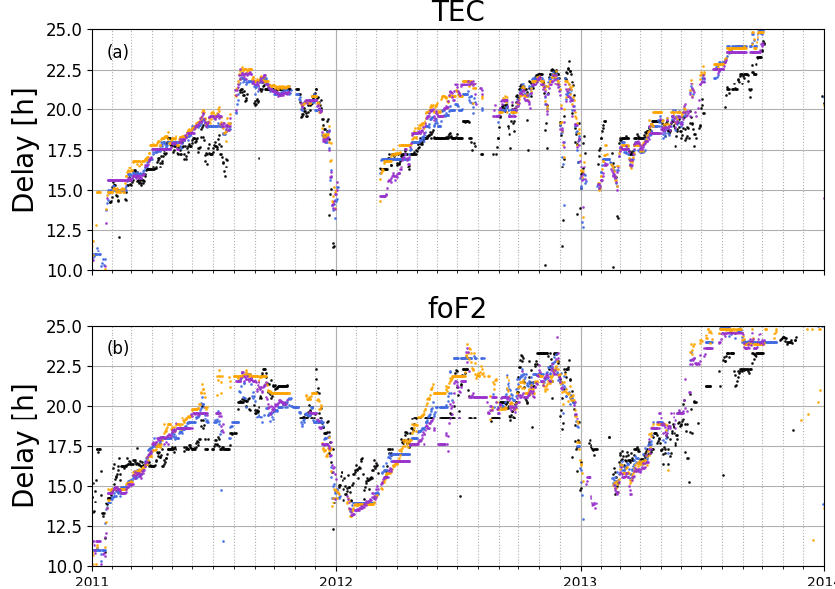
Figure 9. The plots show the delays of the ionospheric parameters TEC (a) and fo F2 (b) with integrated EVE fluxes (6 to 105nm) for Tromsø (black), Pr˚uhonice (blue), Rome (orange), and Athens (purple). All parameters were analyzed at an hourly resolution using a time window of 90d and a step size of 1h.